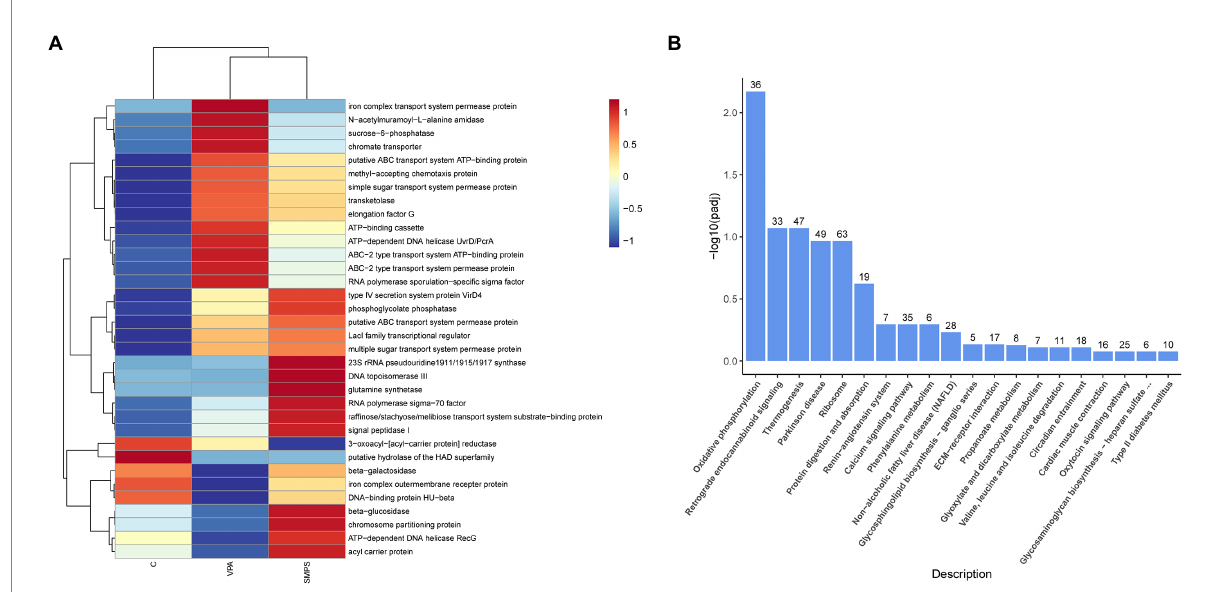
FIGURE 8 The KEGG analysis for transcript and 16S rRNA profiles. (A) Heatmap of functional annotation and abundance information for 16S rRNA profile among SMPS, VPA and C groups; (B) Bar chart of the enrichment pathways between SMPS and VPA